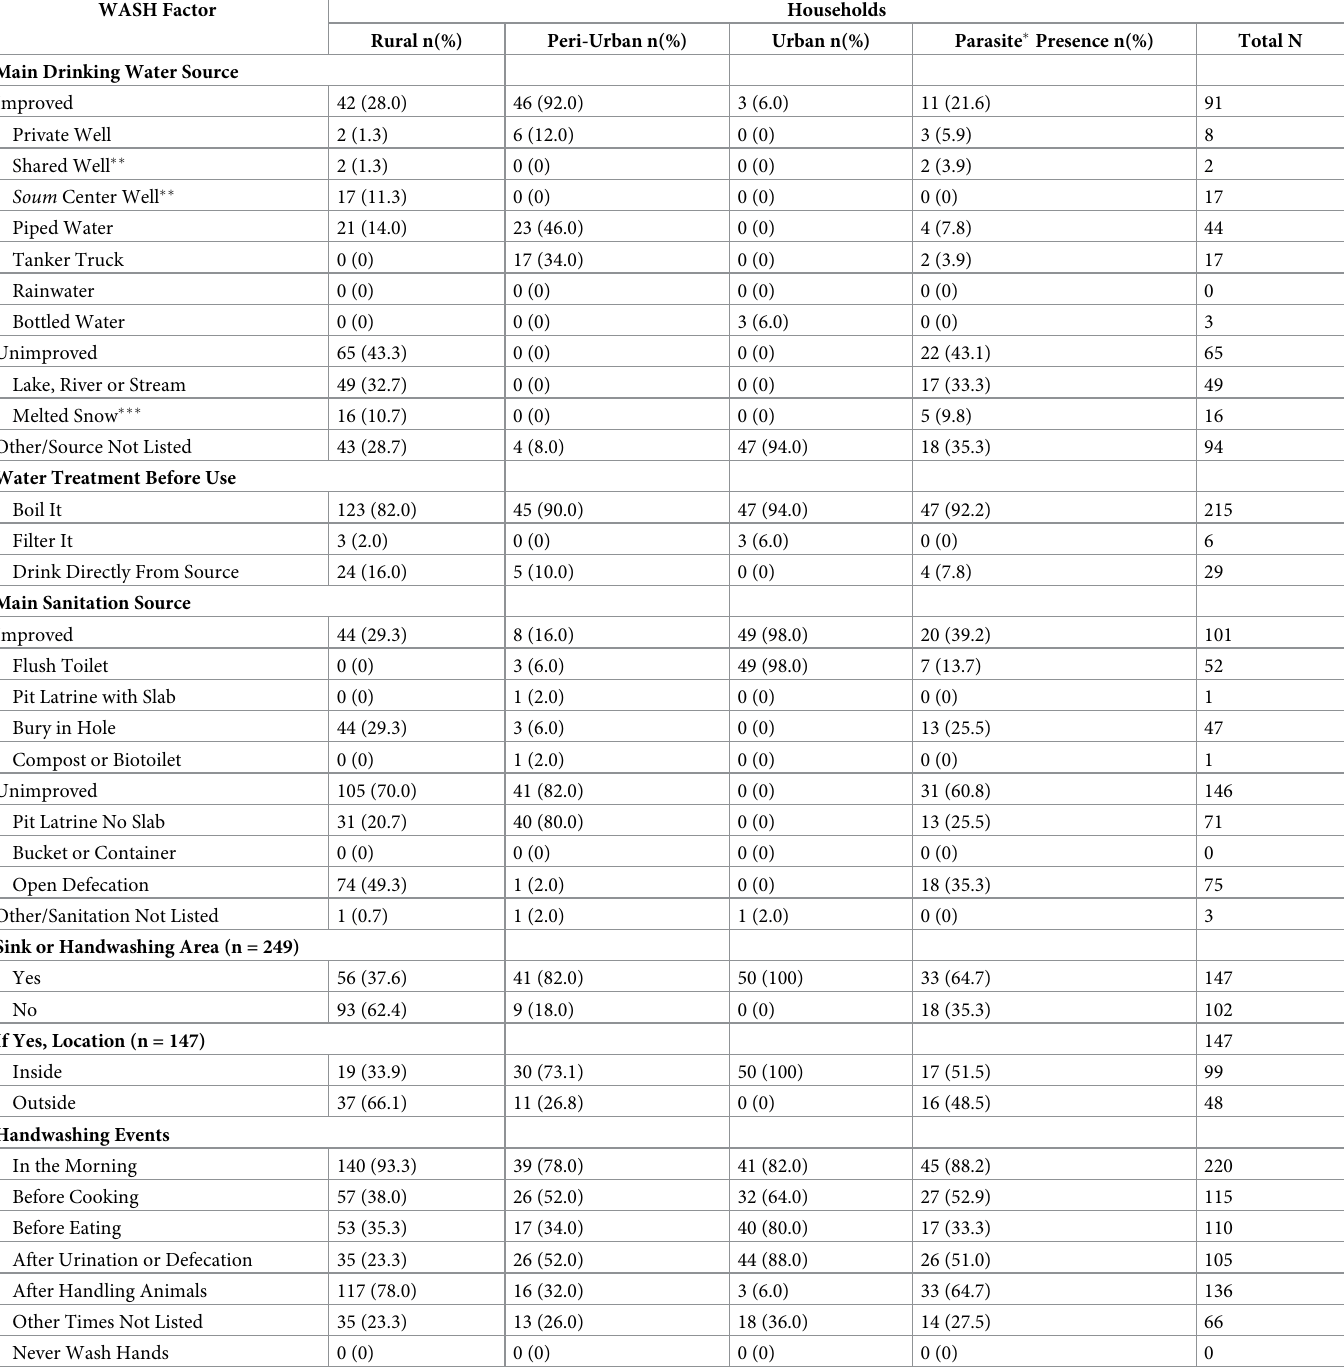
Table 3. Water, Sanitation and Hygiene Access and Behaviors at Rural (n = 150), Peri-Urban (n = 50), and Urban (n = 50) Mongolian Study Households and House- holds with Zoonotic Enteric Parasite Prevalence (n =